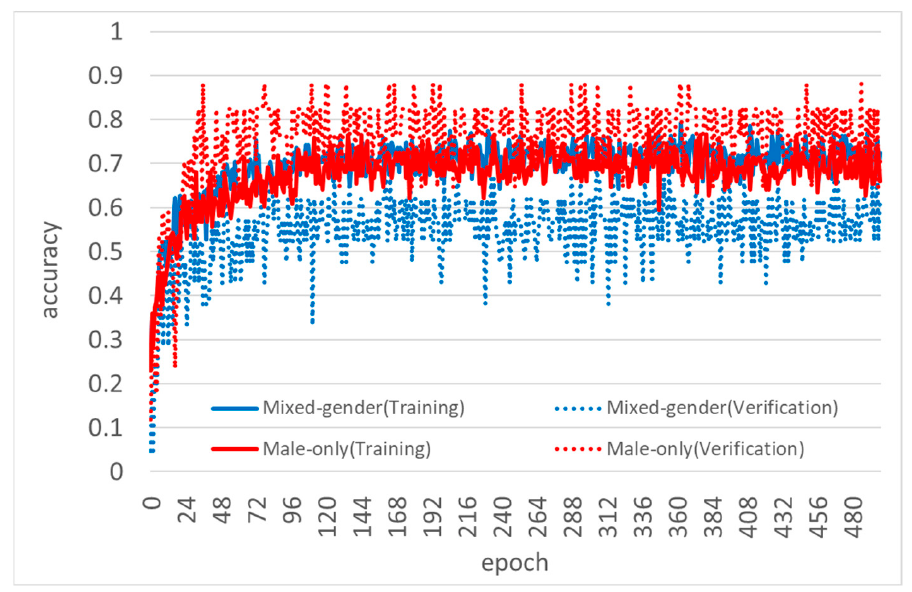
Figure 5. Progress of learning of training and validation data (accuracy).